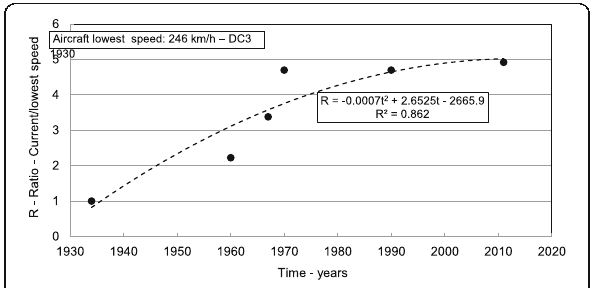
Fig. 2 Development of the aircraft speed over time